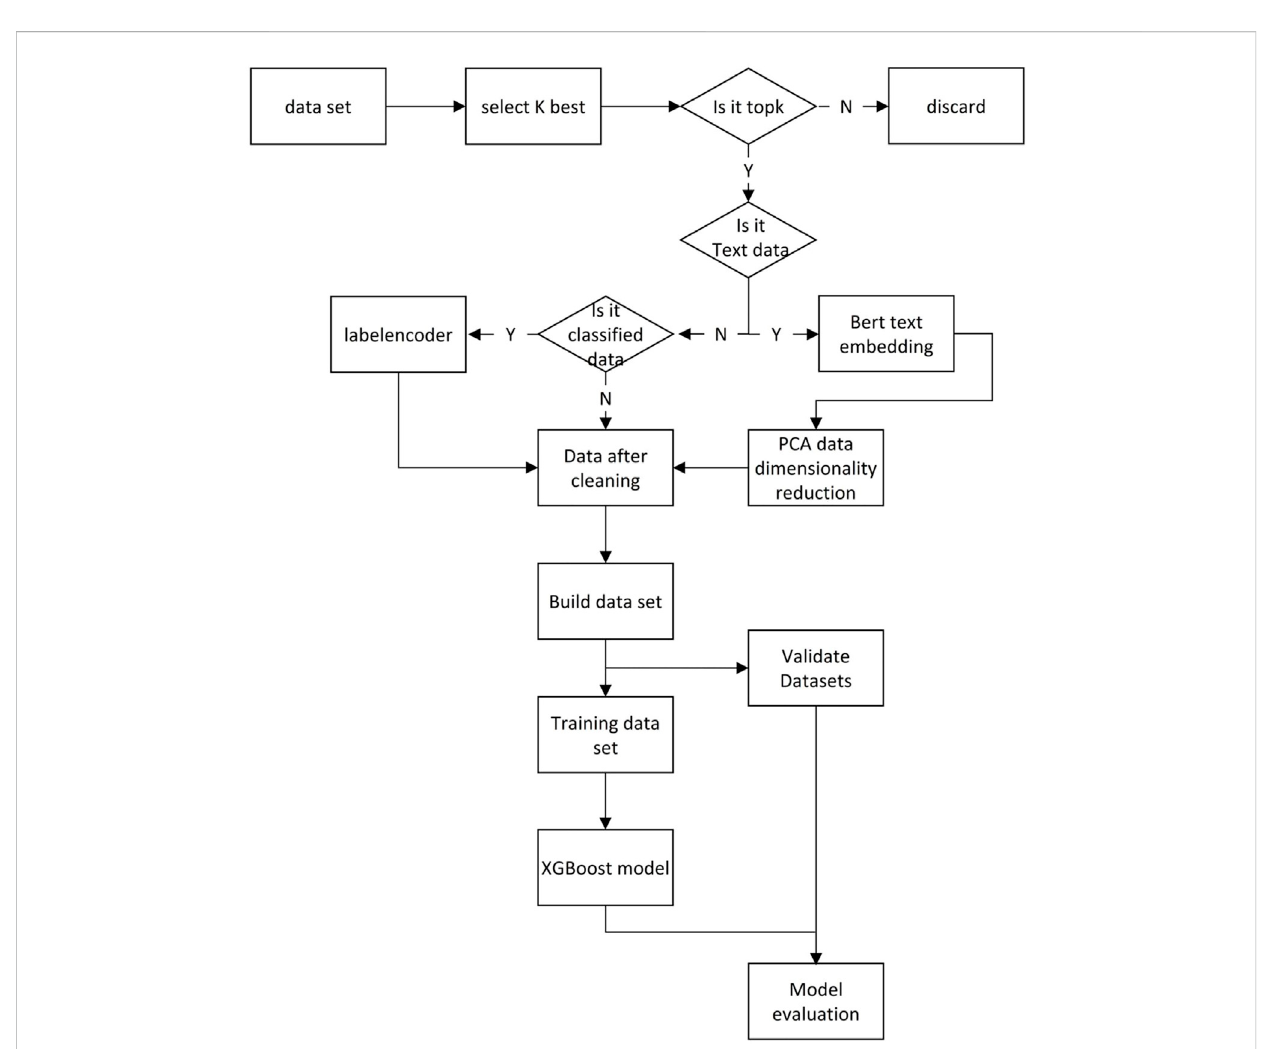
FIGURE 2 Flow chart of the BERT